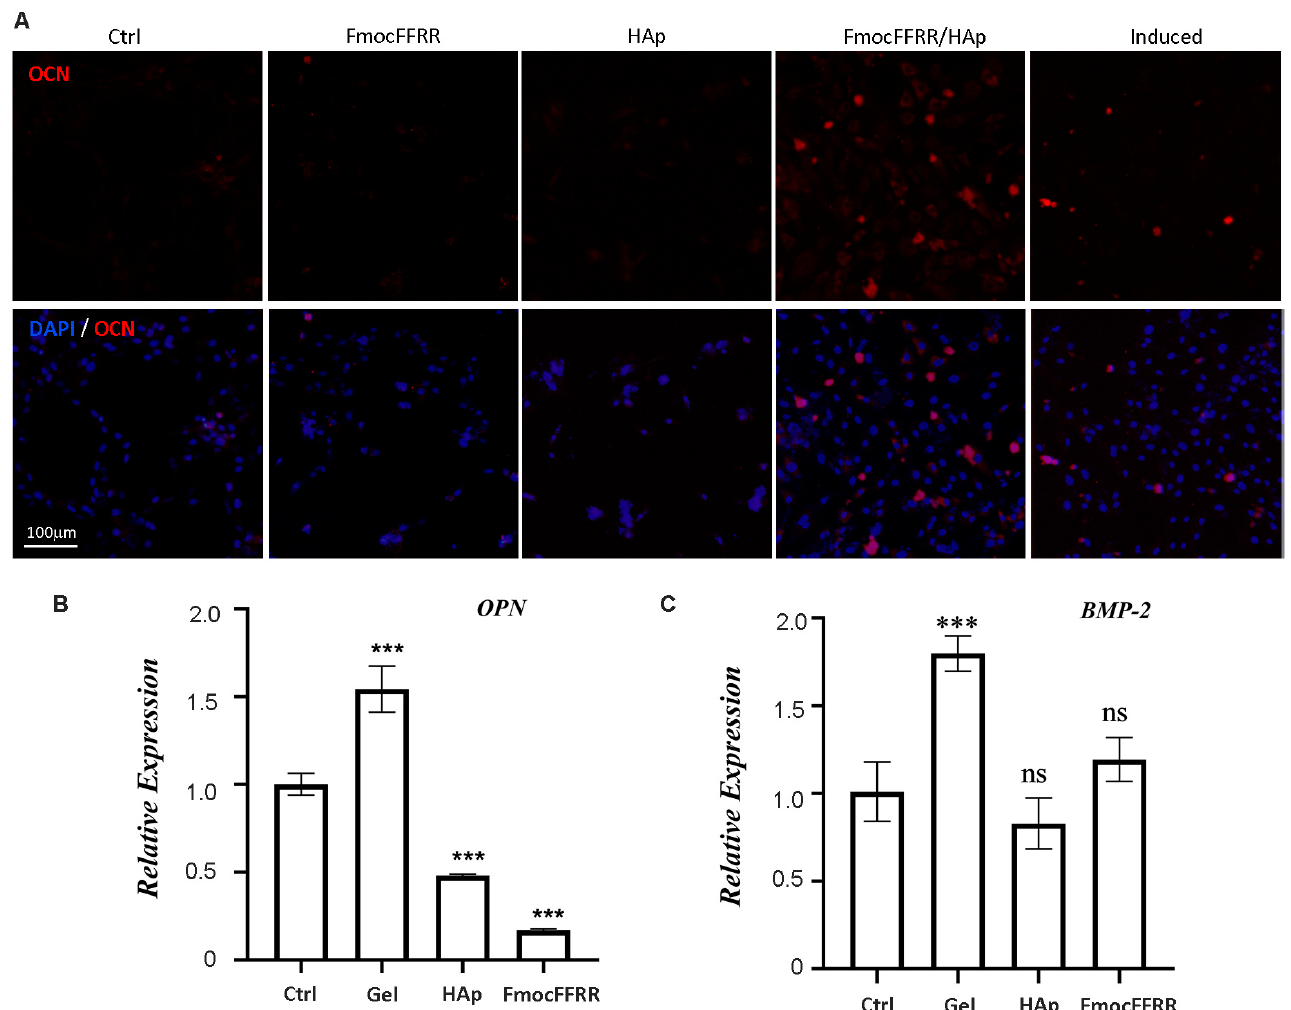
Figure 7. MC3T3-E1 cells were cultured with basal culture medium in FmocFFRR/HAp (5.0/10.0, mg/mL) hydrogel, free HAp particles (10.0 mg/mL), FmocFFRR assemblies (5.0 mg/mL), or treated with osteoinduction medium (Induced) for 7 days. ( A ) Protein expression of OCN was immunostained with an anti-OCN antibody. Cell nuclear was also stained with DAPI. Gene expression of osteogenesis markers OPN ( B ) and BMP-2 ( C ) was quantified using qRT-PCR. The expression of GAPDH was used as an internal standard. Data were shown as mean ± SD, n = 6; *** p < 0.001.